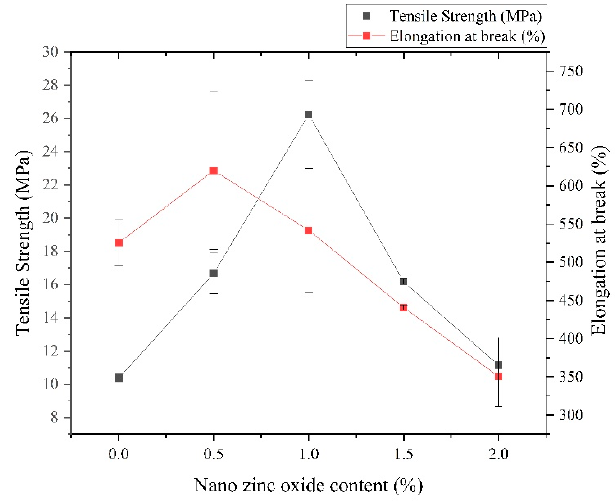
Figure 10. E ff ect of nano-ZnO content on the mechanical properties of composite Figure 10. Effect of nano-ZnO content on the mechanical properties of composite films.